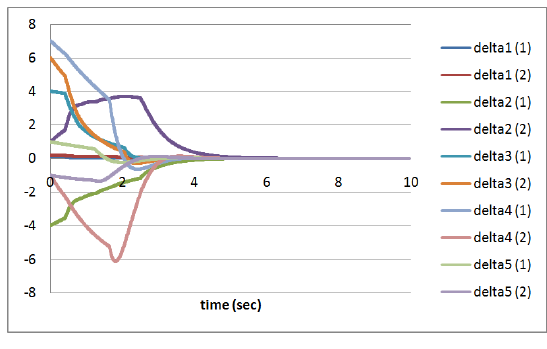
i   trajectories under known Figure 2. Agents , 1 ,..., 5 i dynamics.